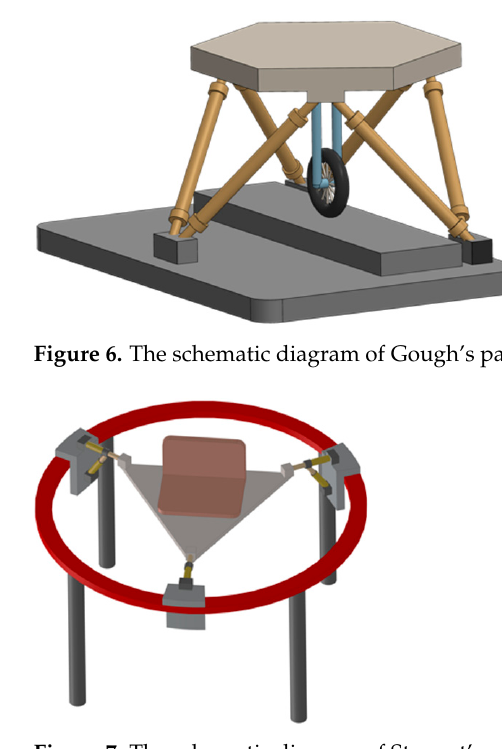
Figure 7. The schematic diagram of Stewart’s parallel mechanism.